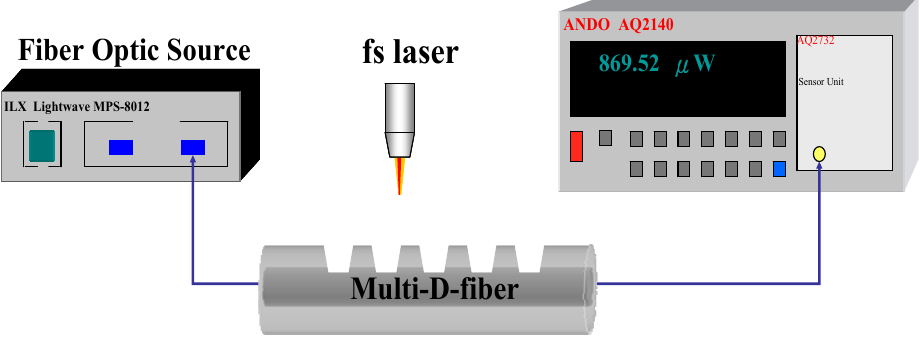
ANDO AQ2140 869.52 μ W